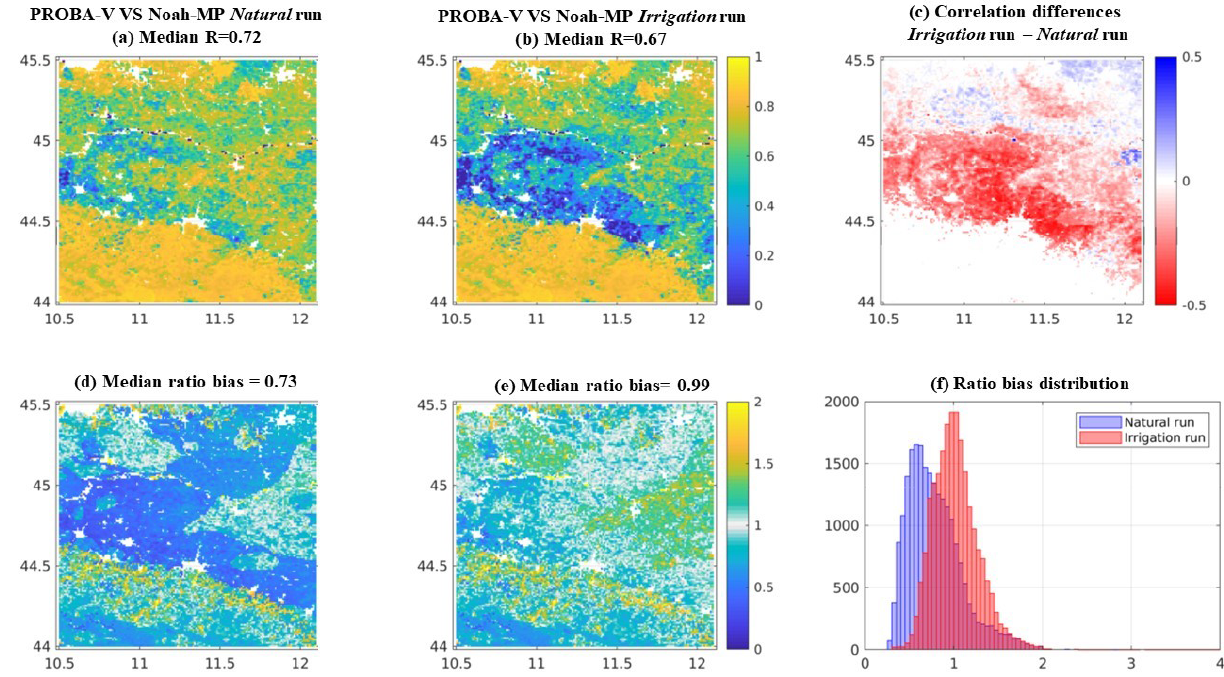
Figure 5. Maps of temporal Pearson R between 10d LAI values from PROBA-V LAI and Noah-MP LAI. (a) Natural run. (b) Irrigation run. Map of Pearson R differences between (c) map b and map a . Map of the ratio bias of LAI from PROBA-V and Noah-MP, showing the (d) natural run and (e) irrigation run. Additional histogram distributions from (f) map d and map e . The reference period is January 2015–October 2019.